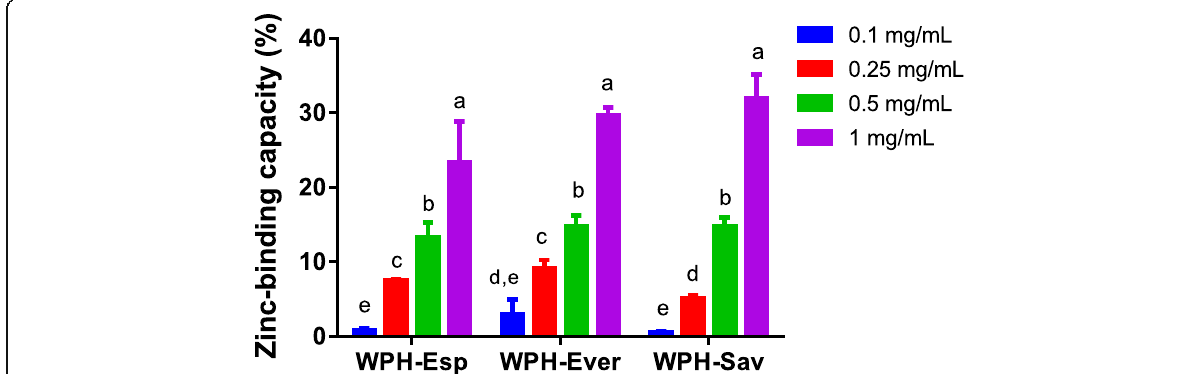
Fig. 1 Zinc-binding capacity of whey protein hydrolysates (WPH) produced with Esperase (WPH-Esp), Everlase (WPH-Ever) and Savinase (WPH- Sav). Bars with different letters are significantly different mean values (P <